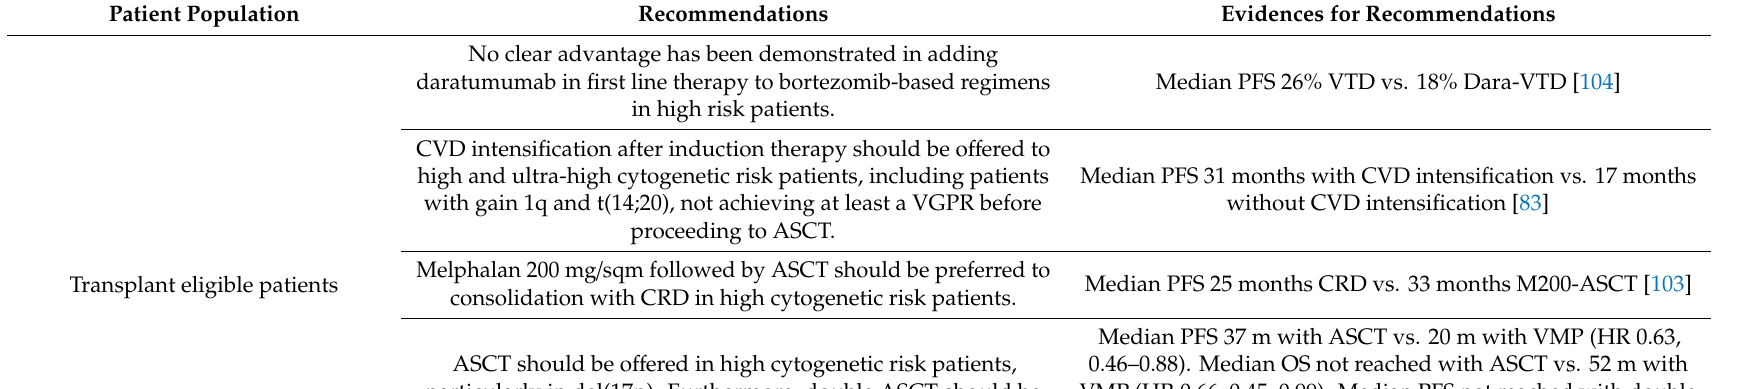
Table 5. Recommendations of cytogenetic-driven therapy in newly diagnosed multiple myeloma patients. V = bortezomib, D = dexamethasone, C = cyclophosphamide, ASCT = autologous stem cell